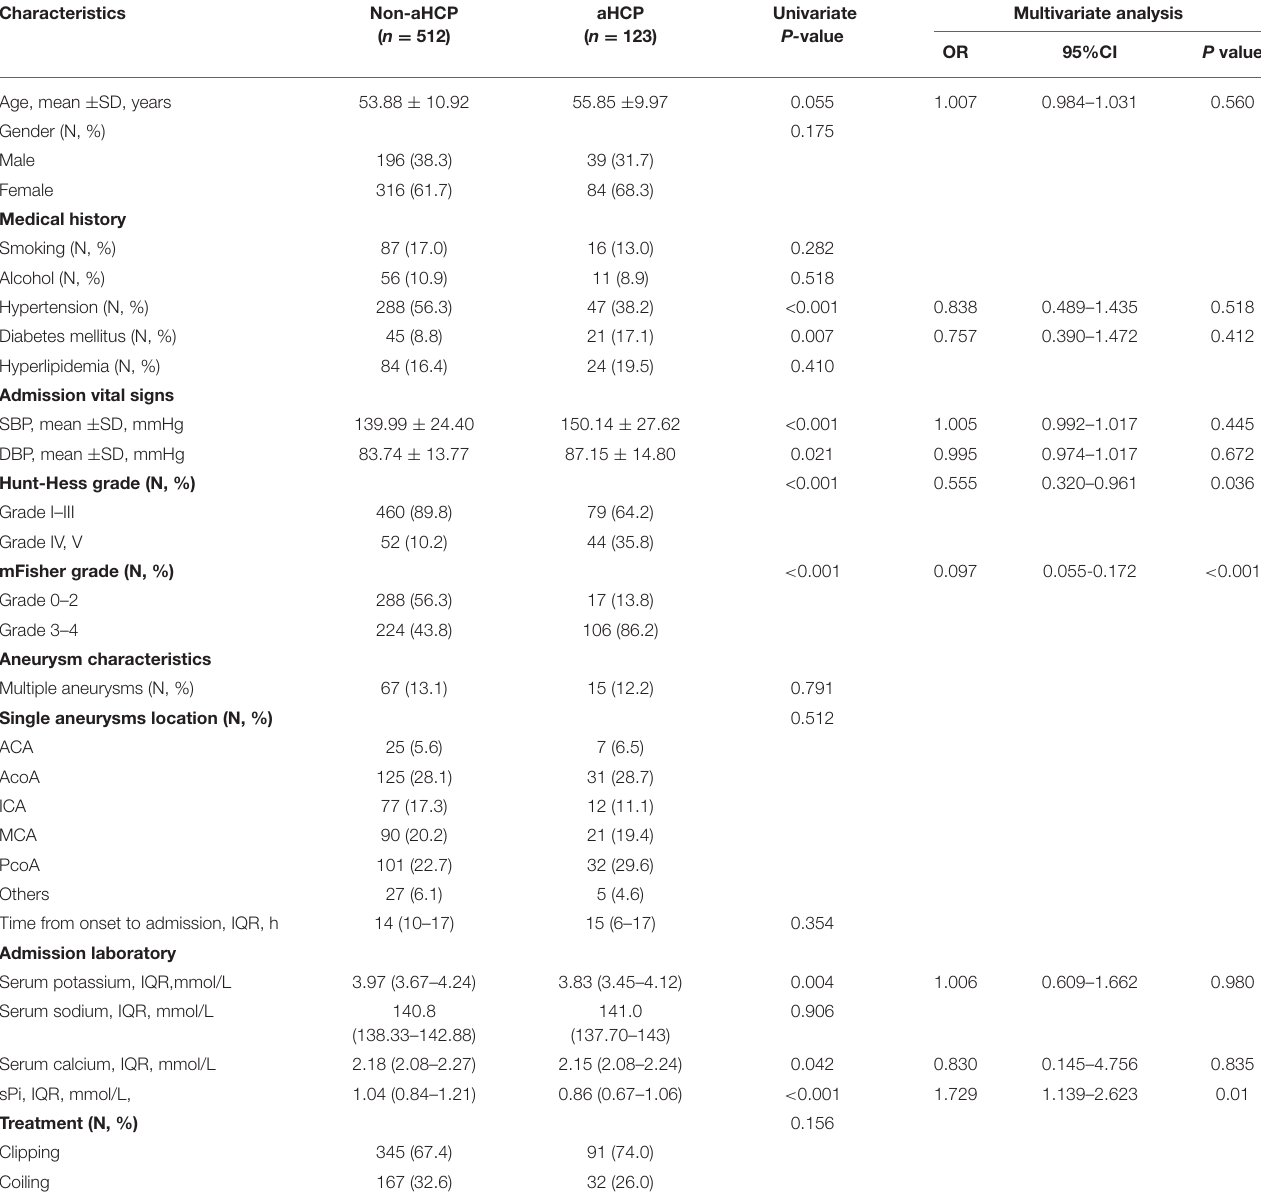
TABLE 1 | Univariate and multivariate analyses of association with hydrocephalus following aSAH.